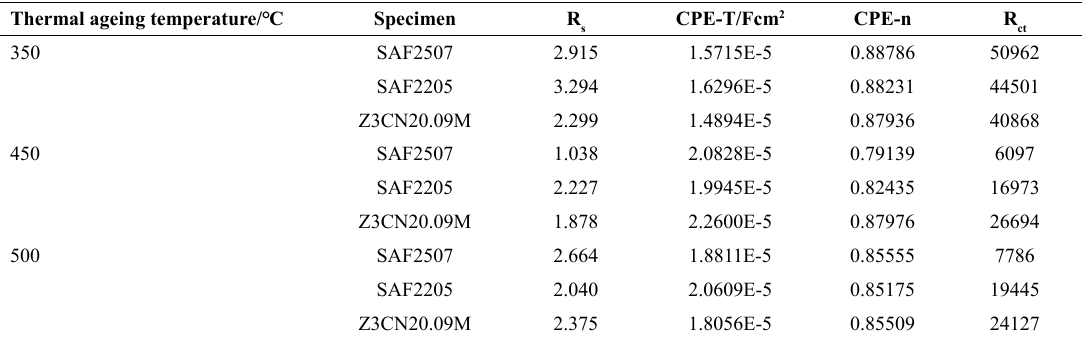
Table 2. EIS-fitted values of three DSS specimens in 0.5 mol L −1 NaCl solution. Thermal ageing temperature/℃